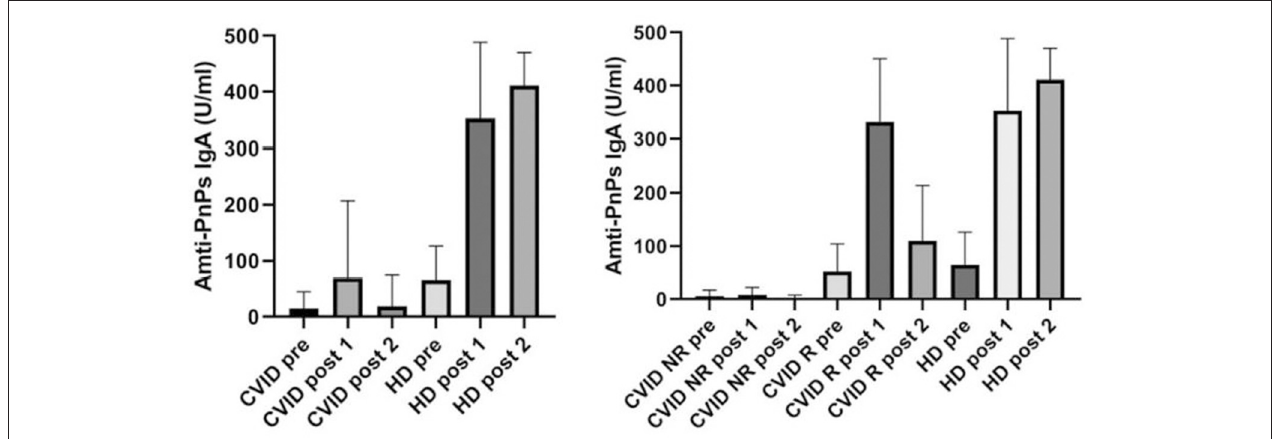
FIGURE 1 | Specific PnPS IgA antibodies in healthy controls and CVID patients before vaccination (pre), 4 weeks after vaccination (post 1) and after 36 ± 6 months (post 2). CVID patients are classified as not responders (NR) and responders R according to IgA specific response.